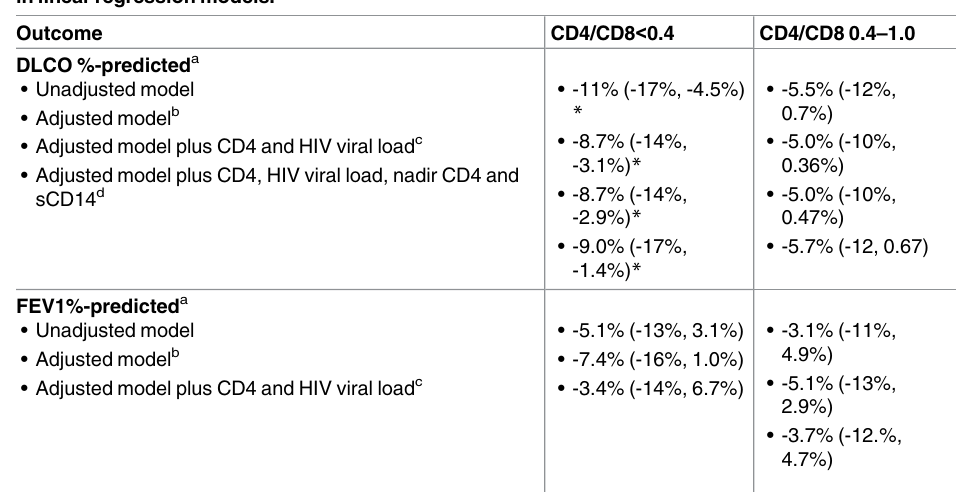
a Estimate of difference in %-predicted values (95% CI) for CD4/CD8 ratios relative to ratio > 1.0 b Model adjusted for age, sex, race/ethnicity, BMI, pack-years of tobacco use, chronic diseases (chronic heart disease, anemia, diabetes, hypertension) and inhalational and intravenous drug use c Adjusted model with additionalinclusion of CD4 cell count and viral load d Adjusted model with additional inclusion of CD4 cell count, viral load, nadir CD4 and soluble CD14 * P <